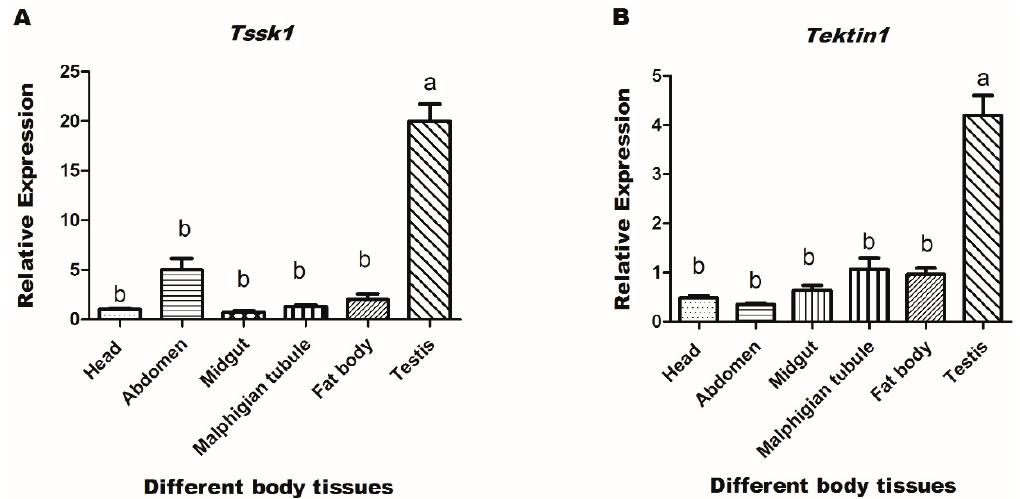
Figure 3. Expression profiles of two genes in di ff erent body tissues of B. dorsalis males. ( A ) Expression profiles of Tssk1 in di ff erent body tissues. ( B ) Expression profiles of Tektin1 in di ff erent body tissues. Di ff erent letters above the bars indicate significant di ff erences (least significant di ff erence) in one-way ANOVA at p <